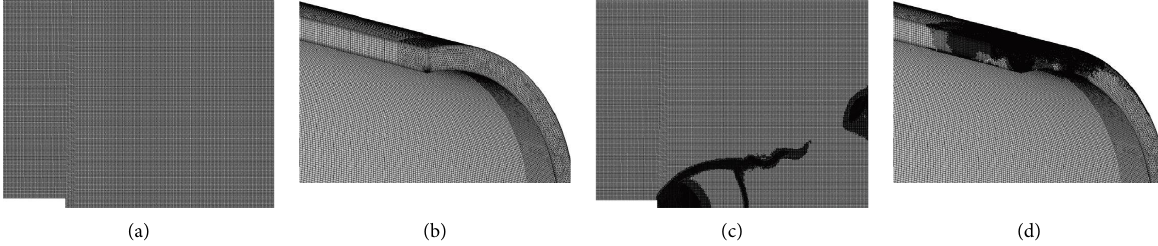
Figure 2: Grid system with dynamic gradient-based mesh adaptation: (a) initial (2D), (b) initial (3D), (c) fnal (2D), and (d) fnal